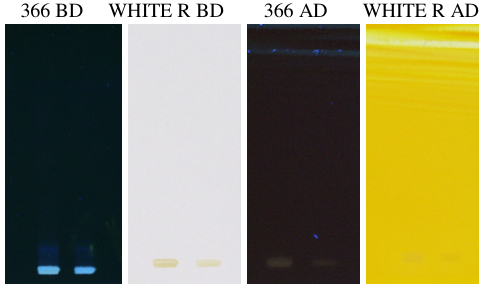
Figure 2. (Plate no 2) HPTLC of alkaloid